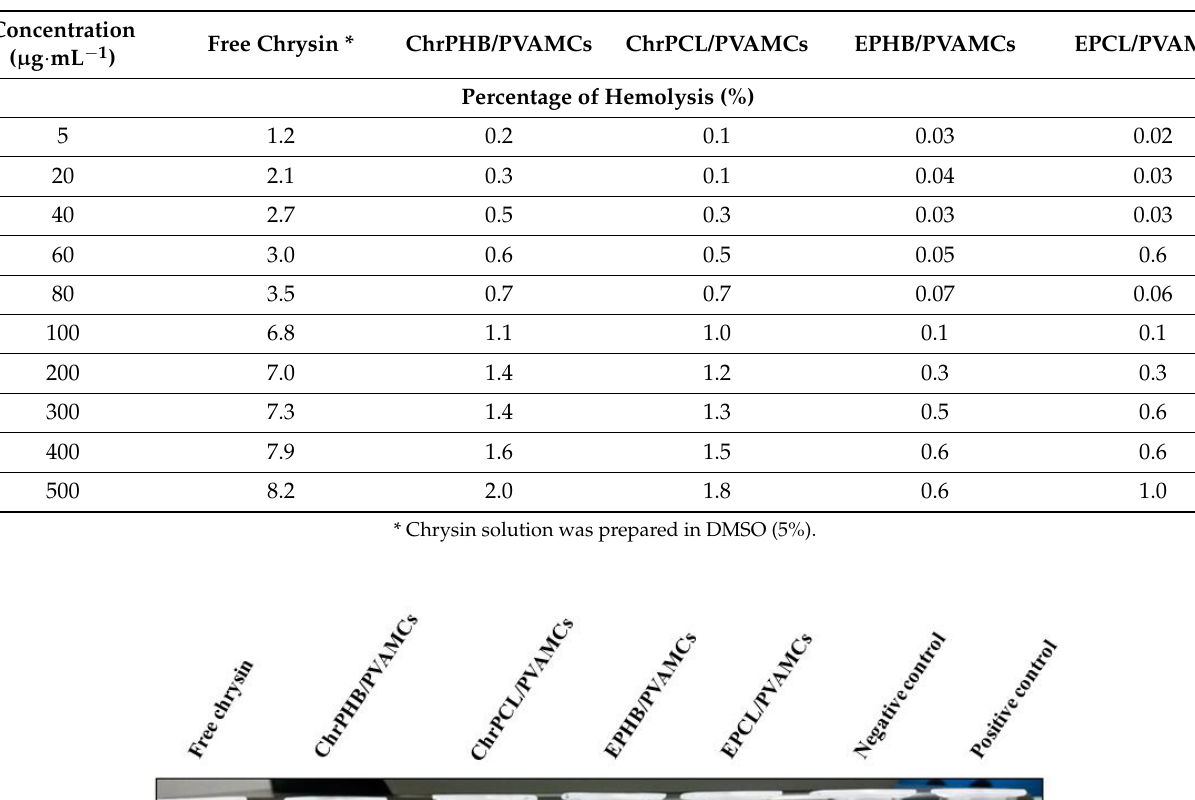
Concentration-dependent hemolytic activity of free chrysin, ChrPHB/PVAMCs, ChrPCL/PVAMCs, EPHB/PVAMCs, and EPCL/PVAMCs.